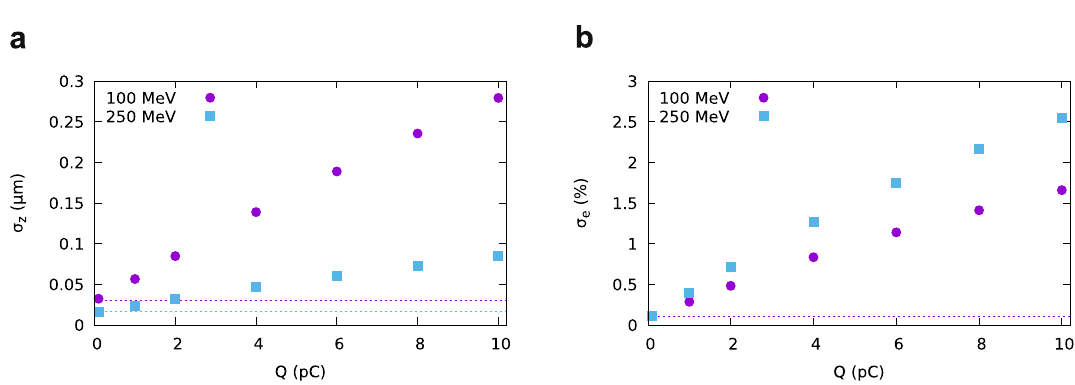
Figure 5. ( a ) Bunch lengthening and ( b ) energy spread growth induced by space-charge forces after 1 m drift in vacuum obtained using GPT for the parameters of Fig. 2 and an electron beam with r.m.s. bunch duration of 50 as and energy of 100 MeV and 250